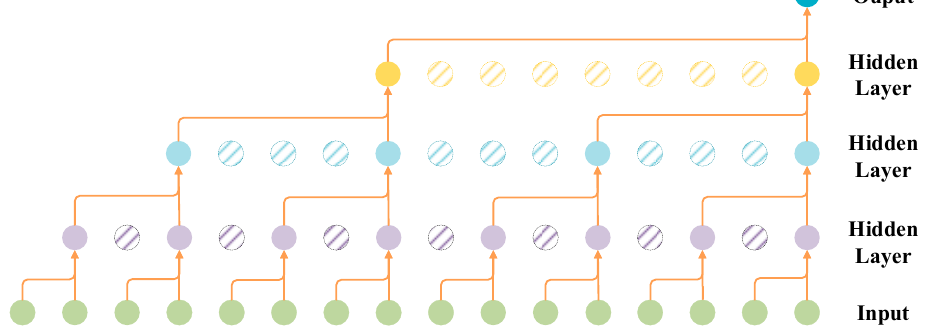
Figure 2. Visualization of a stacked dilated convolutional network.